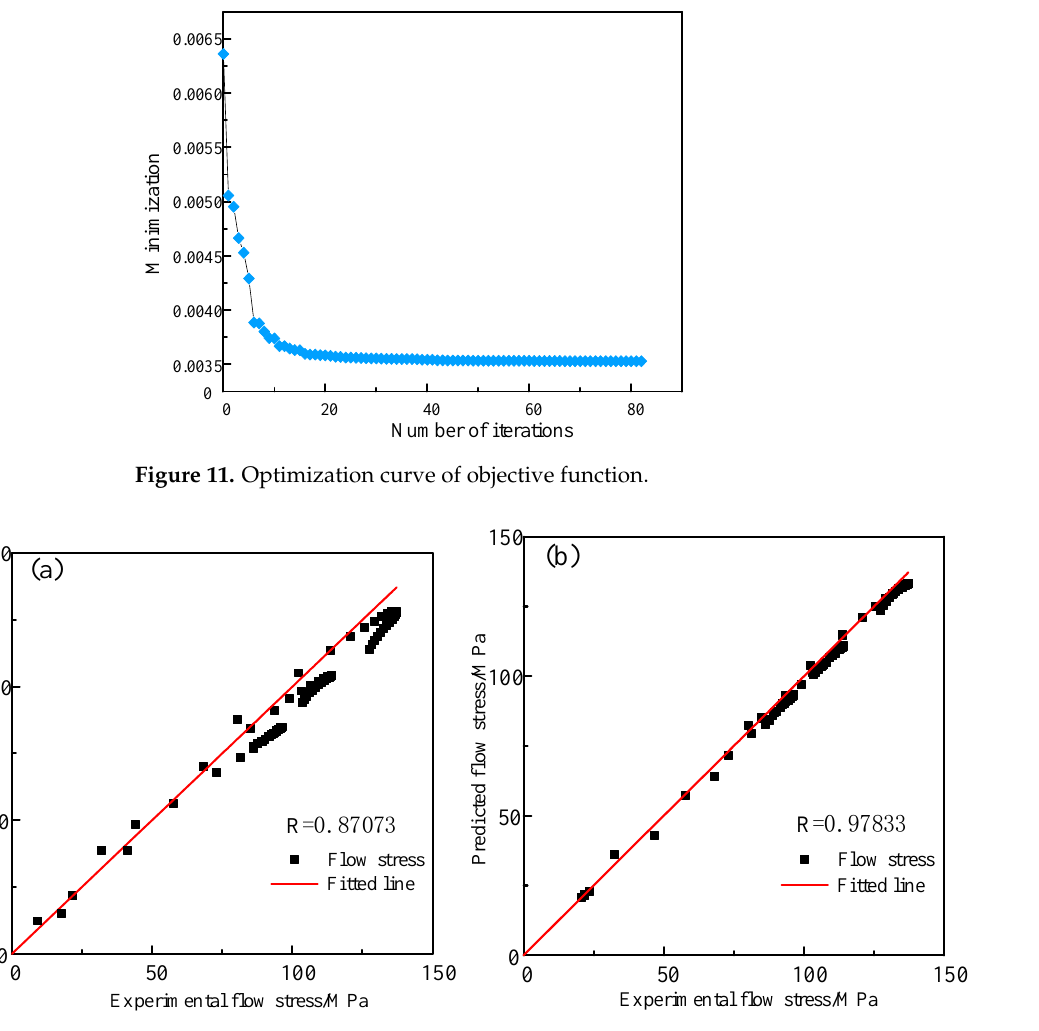
Figure 12. The relationship between experimental flow stress values and predicted flow stress values under different solution methods: ( a ) traditional calibration method, ( b ) adaptive simulated annealing optimization method.